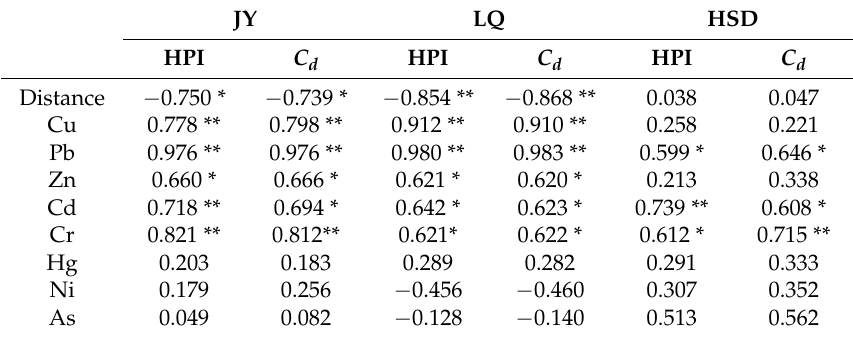
Table 6. Correlation coefficients for the distance and metal concentrations with indices